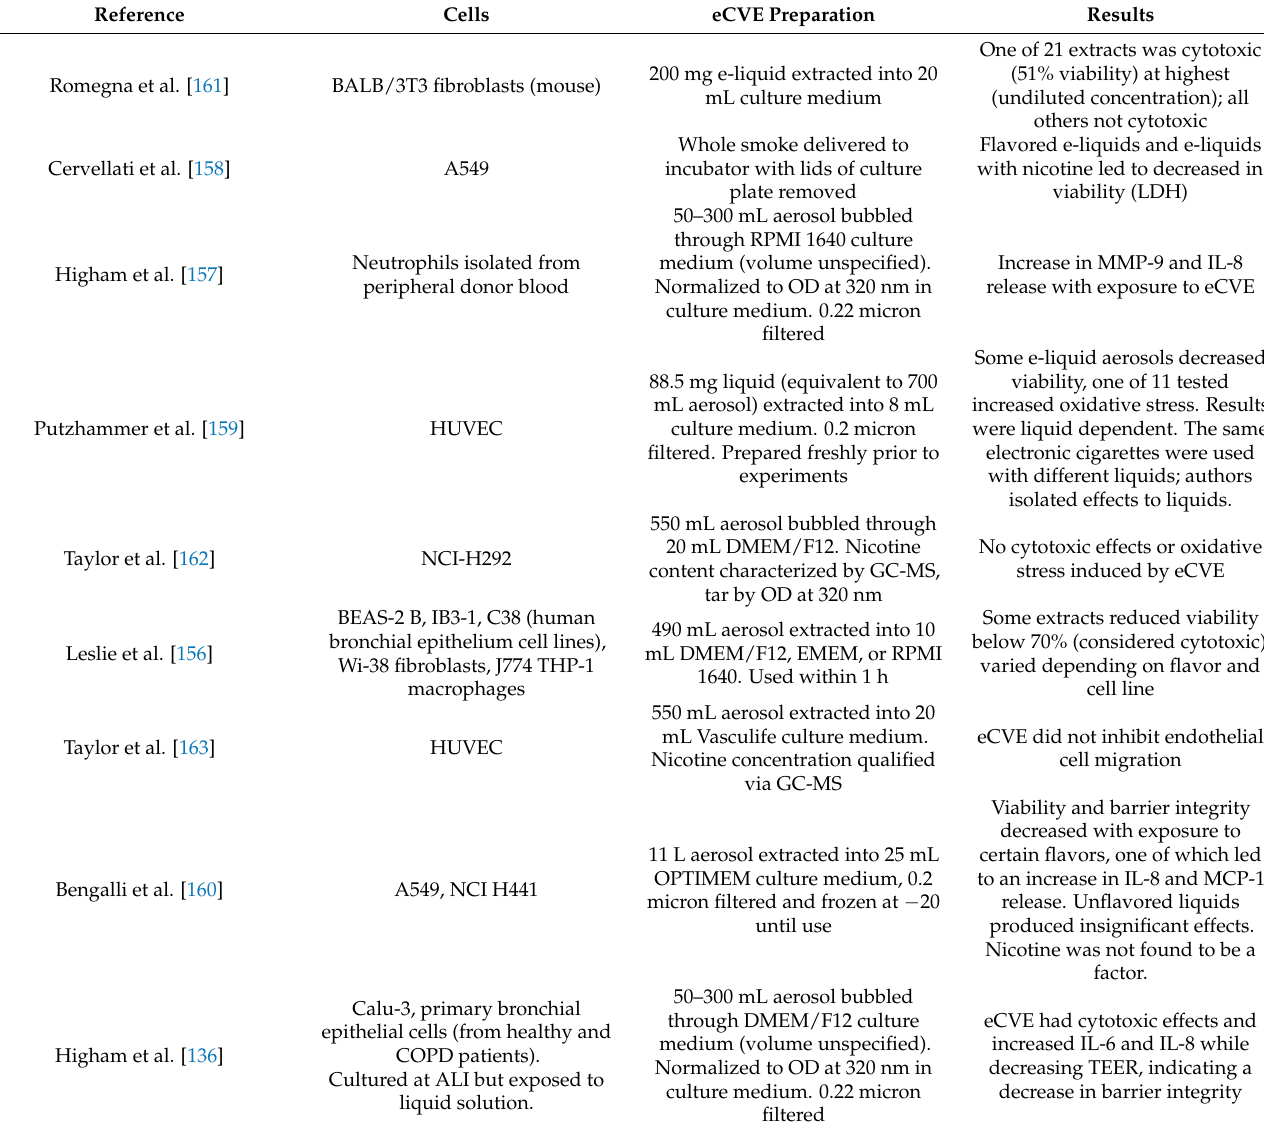
Table 4. Summary of Solution-Based Electronic Cigarette Aerosol